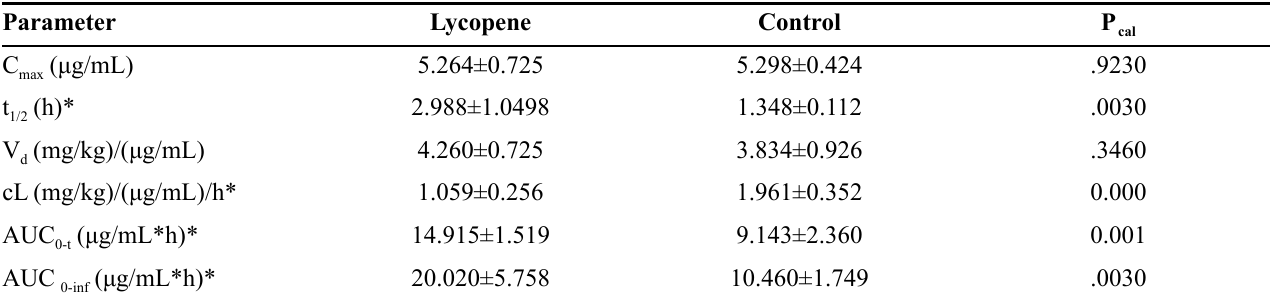
TABLE VI - Statistical analysis of the results obtained by comparing the control group and lycopene group for the determination of pharmacokinetics parameters of chlorozoxazone (20mg/kg) using student’s